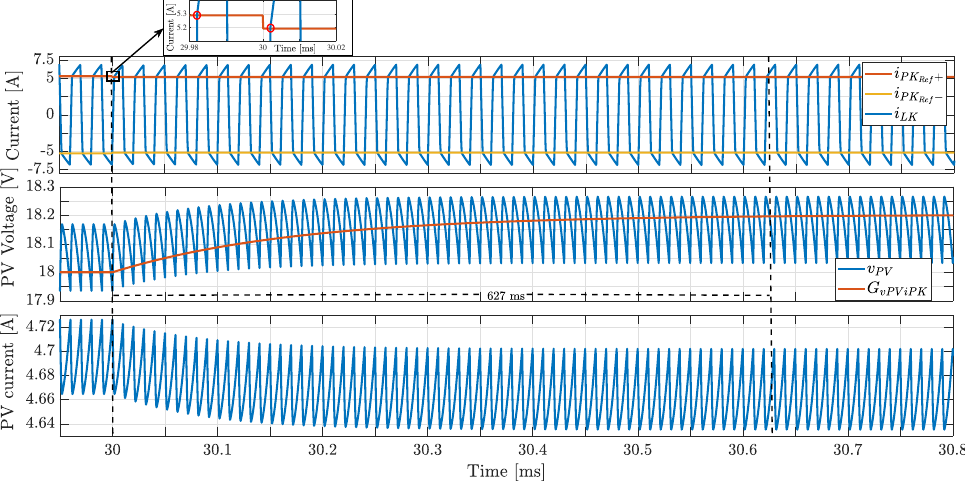
Figure 13. PV current and voltage response for a step change in i PK